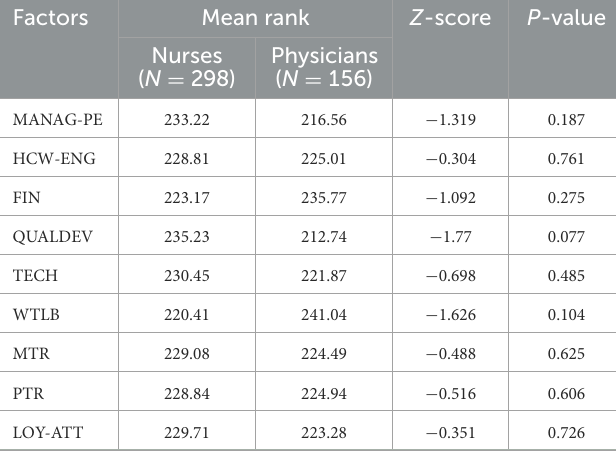
TABLE 3 Variance analysis between physicians’ and nurses’ evaluations for BSC-HCW1 factors.